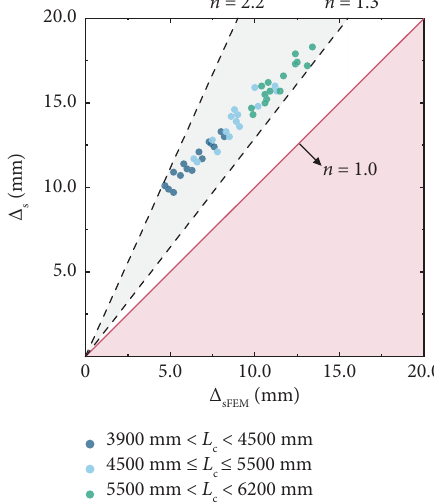
Figure 10: Te scatter plot between the design results ( ∆ Table 6: Te required thickness and the steel area in the stair slabs when θ � 30 ° . L c